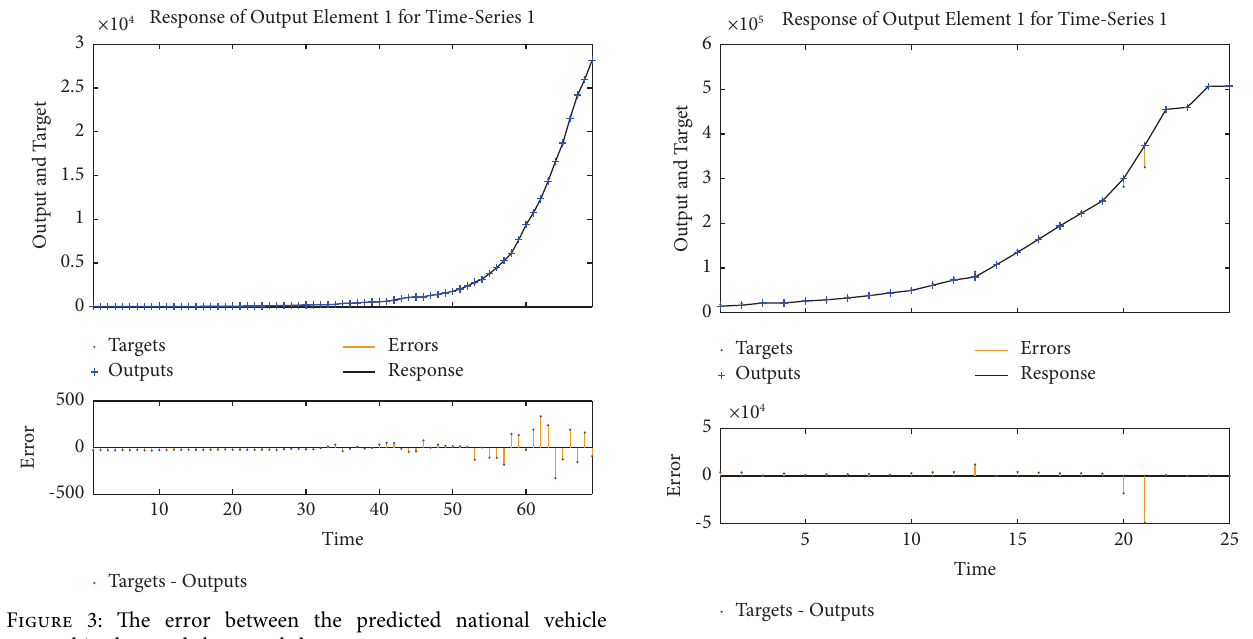
Figure 5: Te error between the predicted car ownership data and the actual data in Cixi City.